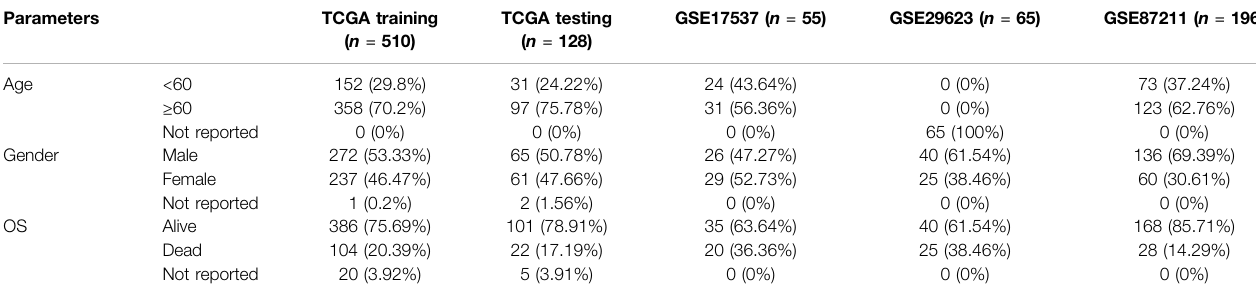
TABLE 1 | Clinicopathological features for each of the enrolled cohorts. Parameters